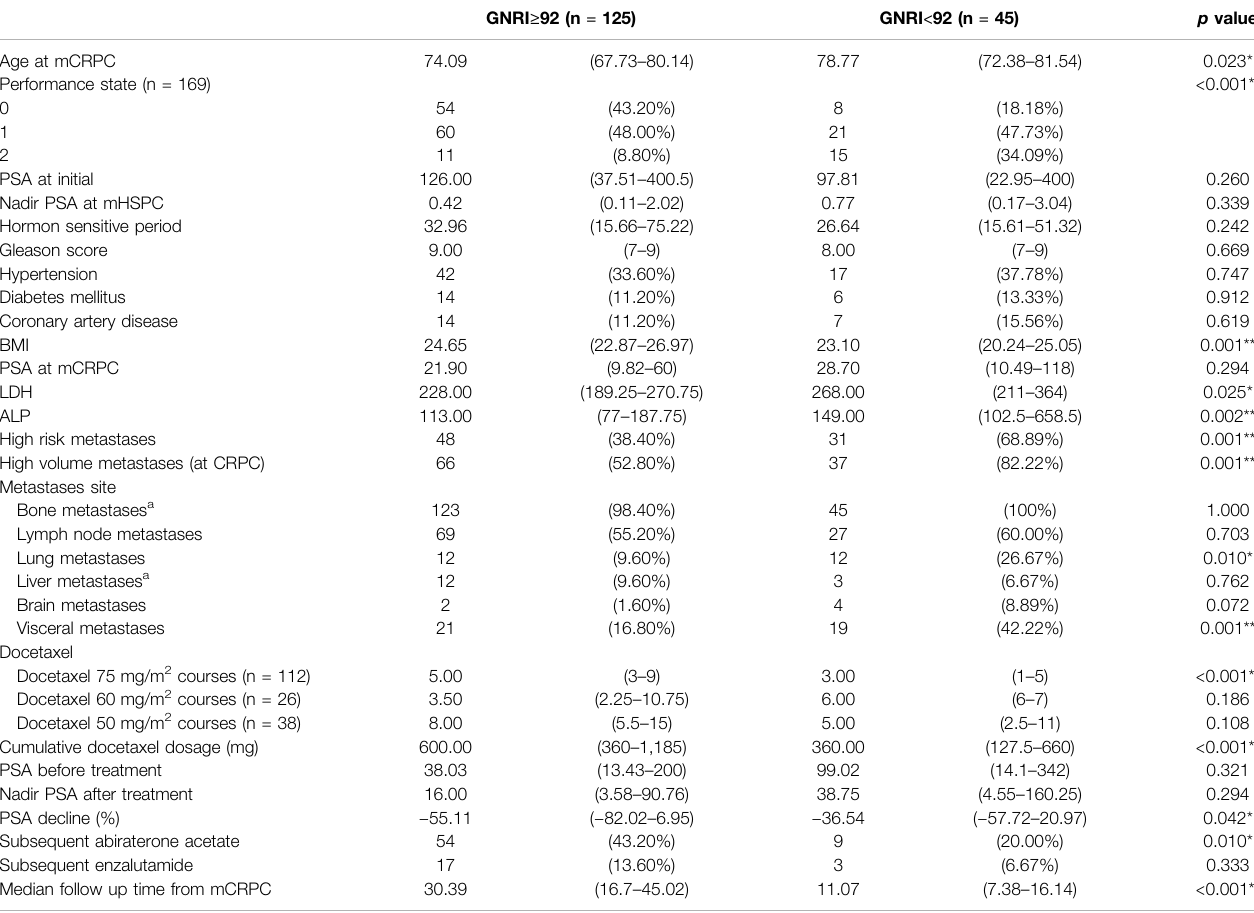
TABLE 1 | Baseline characteristics of patients with